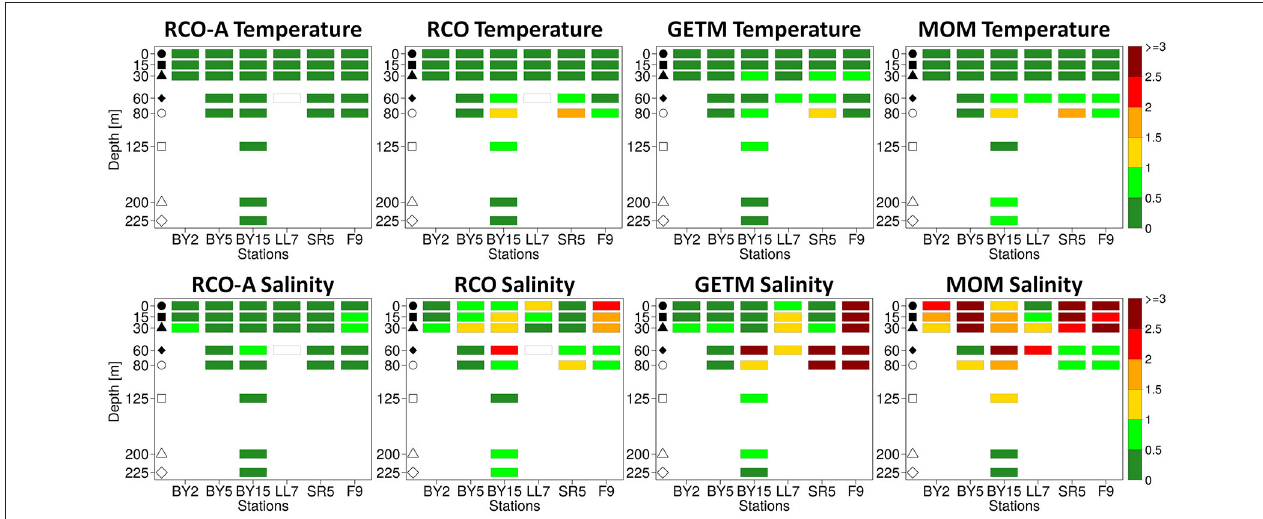
FIGURE 6 | Cost function values derived from monthly time series of sea temperature ( top ) and salinity ( bottom ) from 1970 to 1999 at the six monitoring stations BY2, BY5, BY15, LL7, SR5, and F9. Results from the ocean models RCO-A, RCO, GETM, and MOM (from left to right) compared to the BED observation data are shown at the same depths as illustrated in the Taylor diagrams in Figure 5 . The symbols in the left part of each diagram refer to the depth-dependent plotting symbols from the Taylor diagrams. Blank bins for RCO-A and RCO at LL7 and 60m depth are due to missing data of these models at this location. See text for more details.